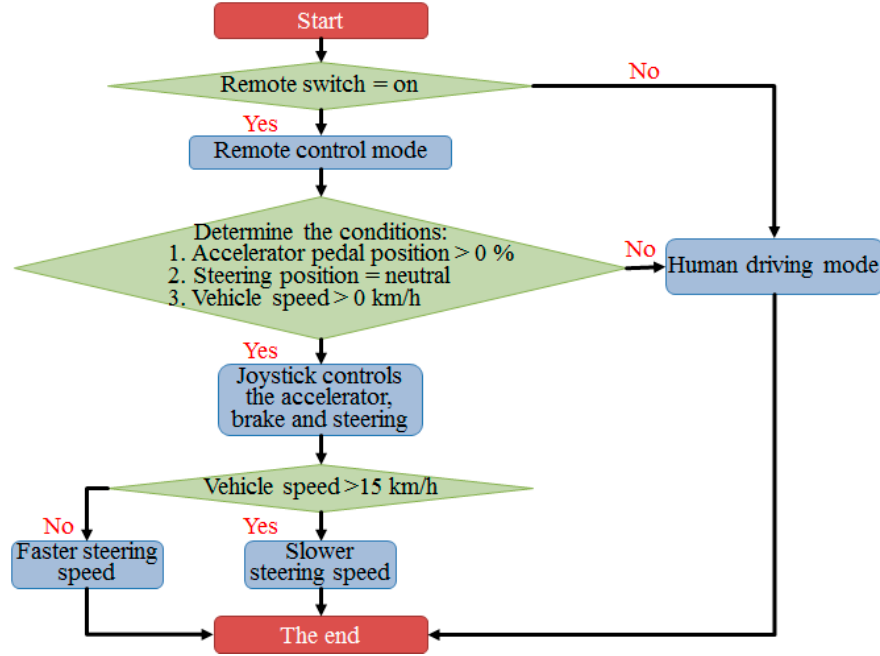
Figure 11. The control flow of the vehicle control unit.